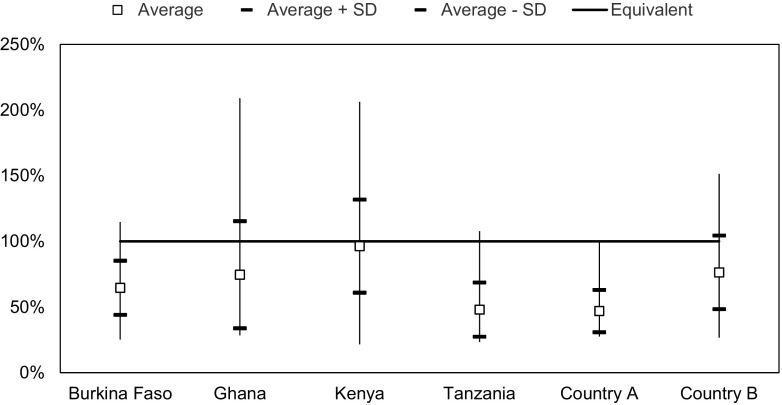
Calculated Consumption (Using Demographic Estimates) as a Percentage of Dispensed-to-User DataAbbreviation: SD, standard deviation.